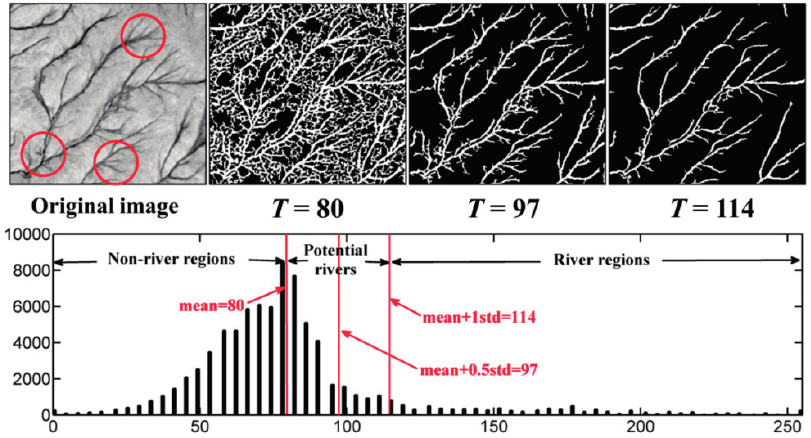
Figure 8. Histogram of the image after Gabor filtering and the path opening process and the corresponding river detection results under different global thresholds. The red circles show the thin rivers considered as potential rivers whose gray values are in the range of mean and mean + 1 std of the image. The value of mean + 0.5 std is considered as an optimal threshold to discern thin rivers from the image